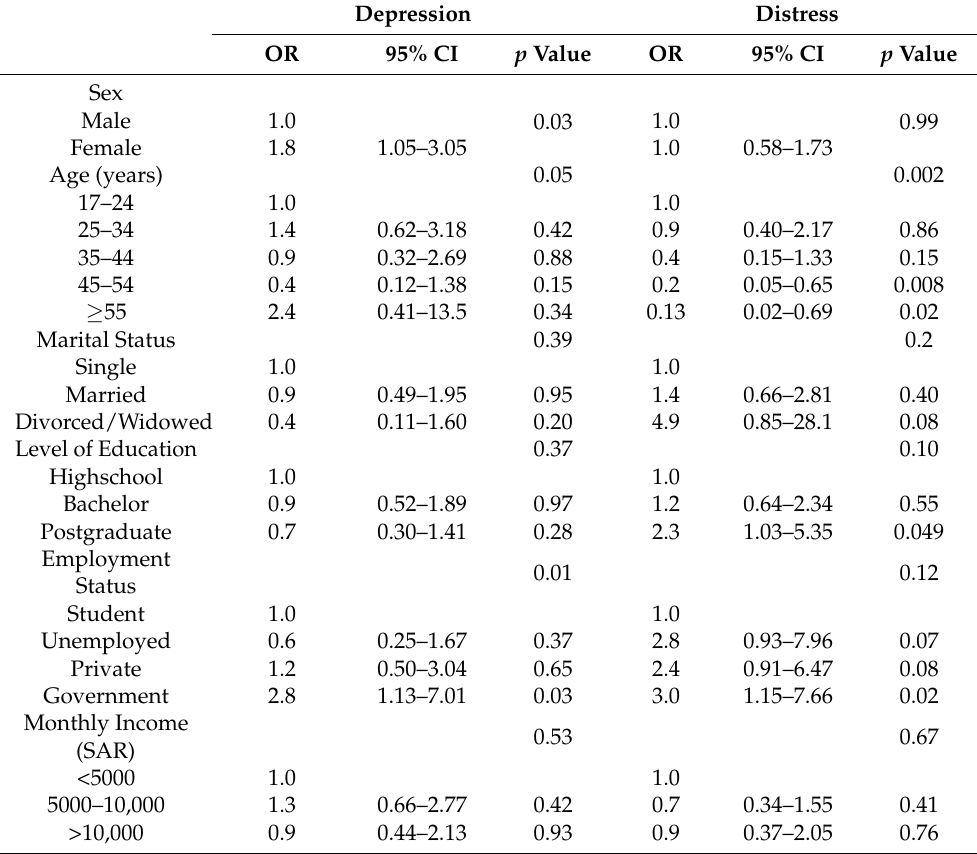
Table 5. Demographic predictors of depression and distress among COVID-19